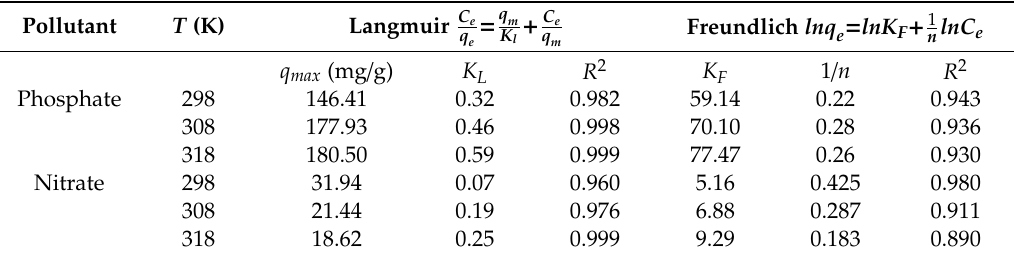
Table 4. Parameters of linear Langmuir and Freundlich isotherm models for phosphate and nitrate adsorption onto B 5 MgAl